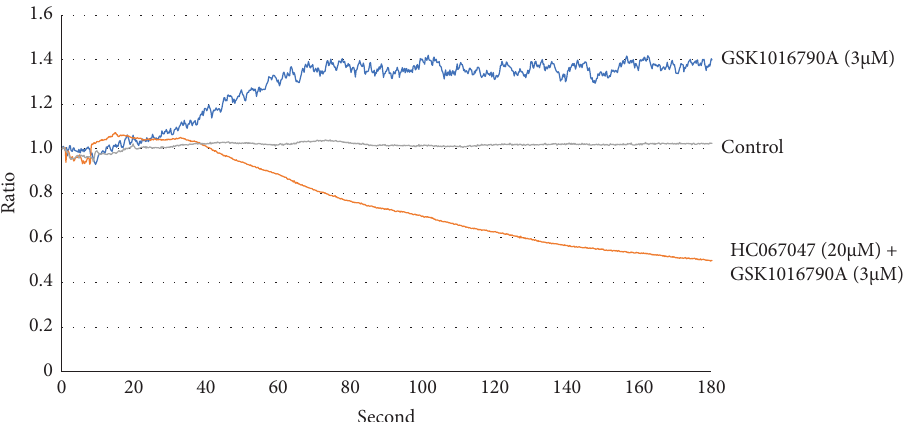
(see Figure 6(d)) (control: 239 ± 16 fmol/ml, n � 5; 120%